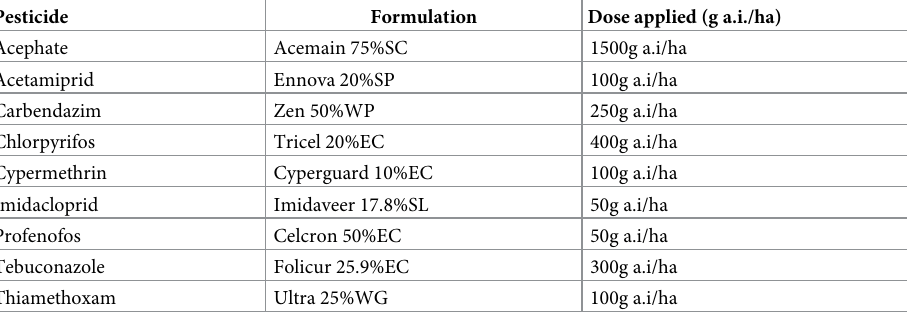
Table 1. Pesticide formulations and applied doses in okra